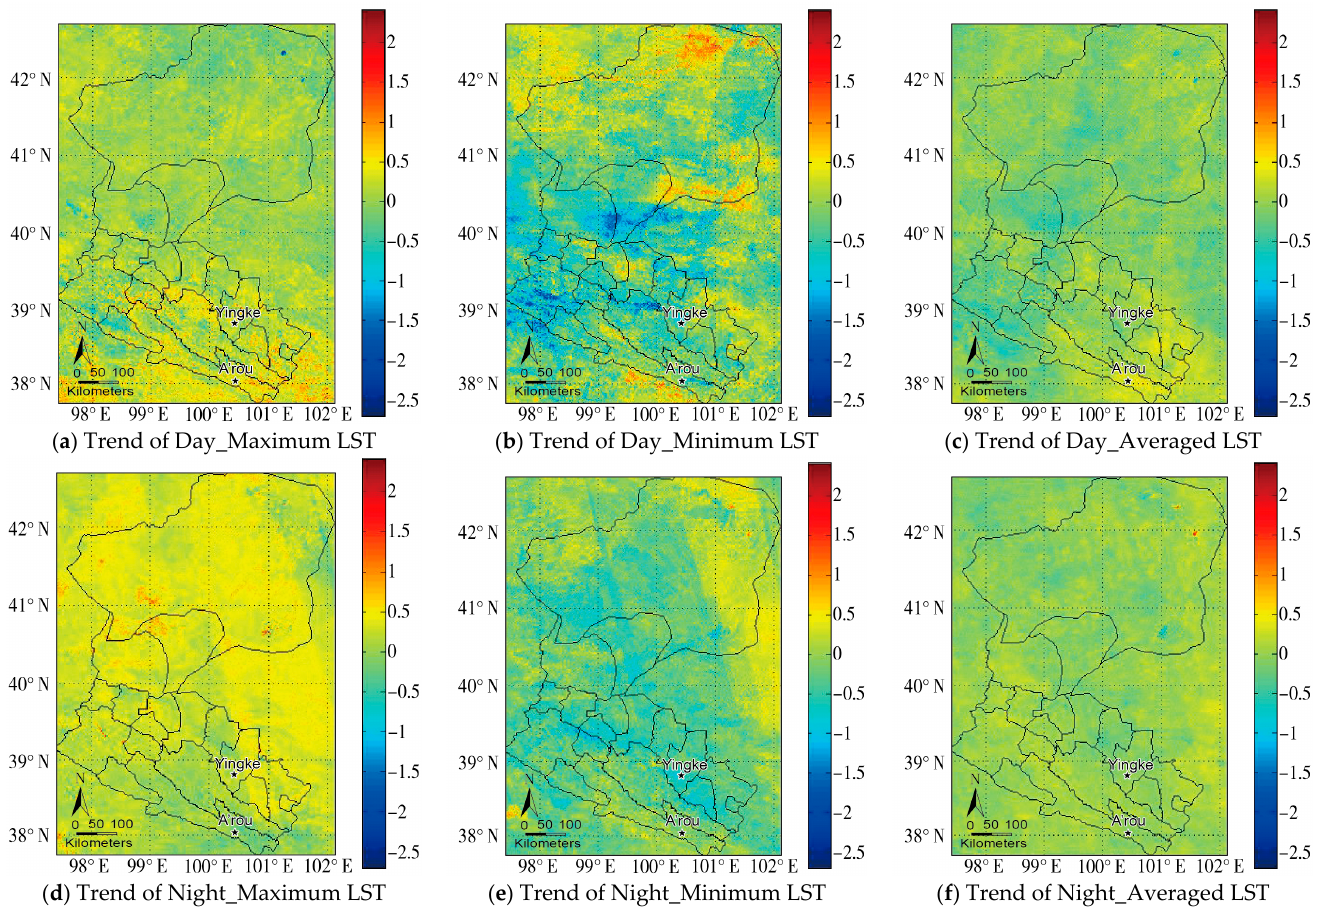
Figure 7. Trend of AATSR-derived annual maximum (minimum, averaged) daytime (nighttime) LST in HRB region for 2003–2011: ( a ) trend of daytime maximum LST; ( b ) trend of daytime minimum LST; ( c ) trend of daytime averaged LST; ( d ) trend of nighttime maximum LST; ( e ) trend of nighttime minimum LST; ( f ) trend of nighttime averaged LST.